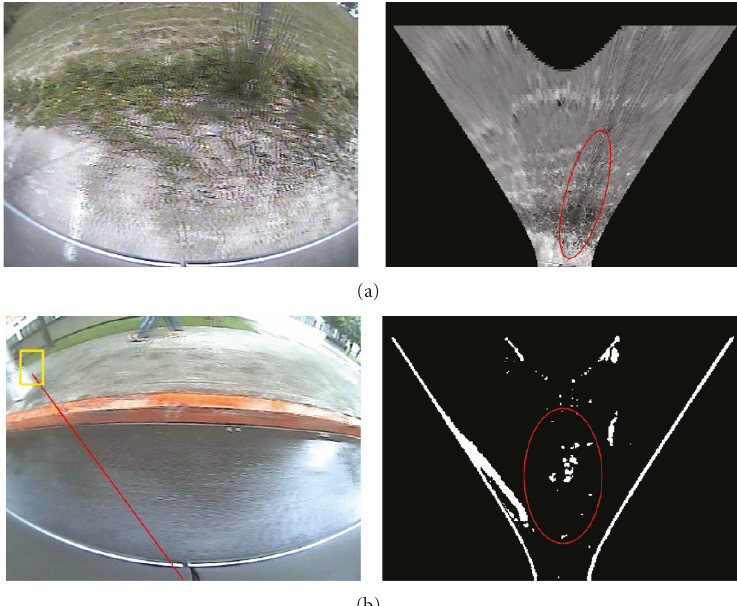
Figure 29: Examples of erroneous detected results in our system.